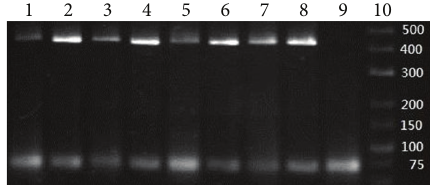
Figure 2: Gel electrophoresis of clinical specimens. Lanes 1, 3, 5, and 7: clinical specimen. Lanes 2, 4, 6, and 8: spiked specimen loaded with RNA of the standard strain of E. coli as positive control. Lane 9: negative control. Lane 10: DNA